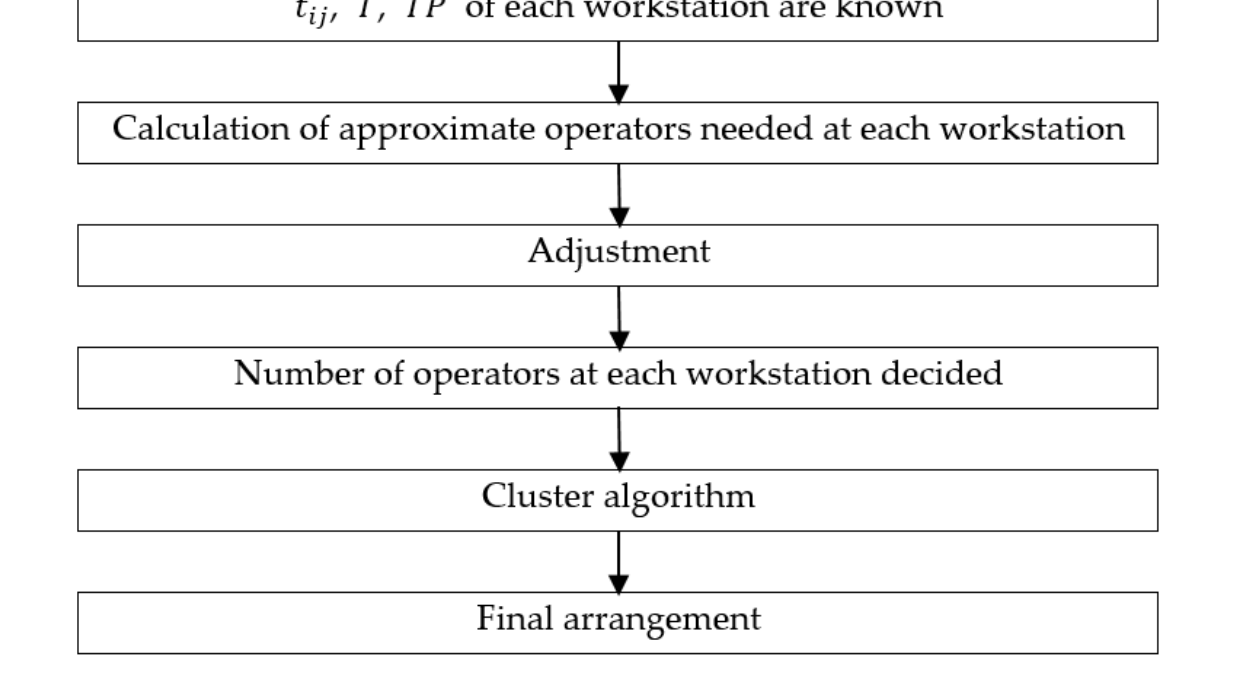
Figure 4. The novel algorithm proposed in this study.